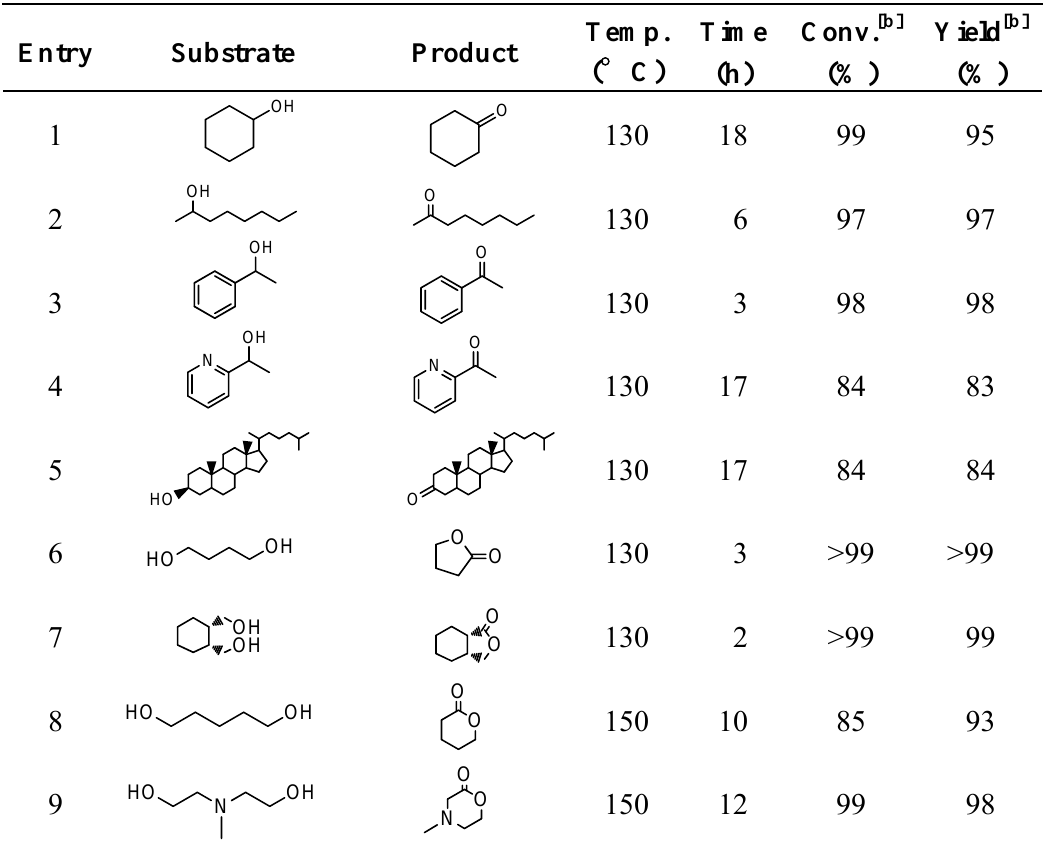
Table 4. Dehydrogenation of Alcohols Using Cu/HT [a]